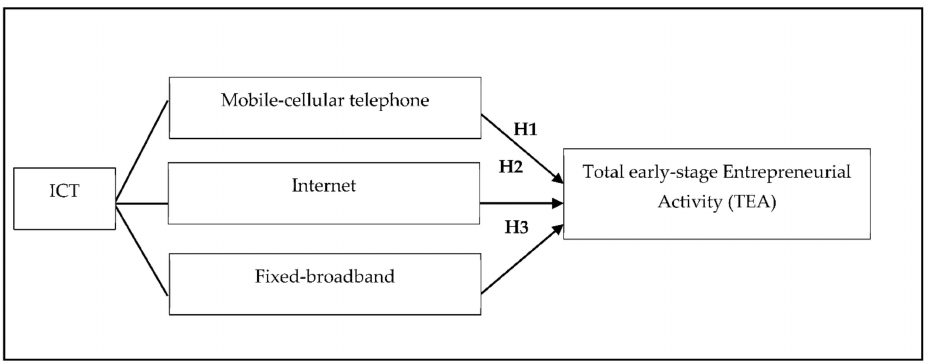
Figure 1. Theoretical